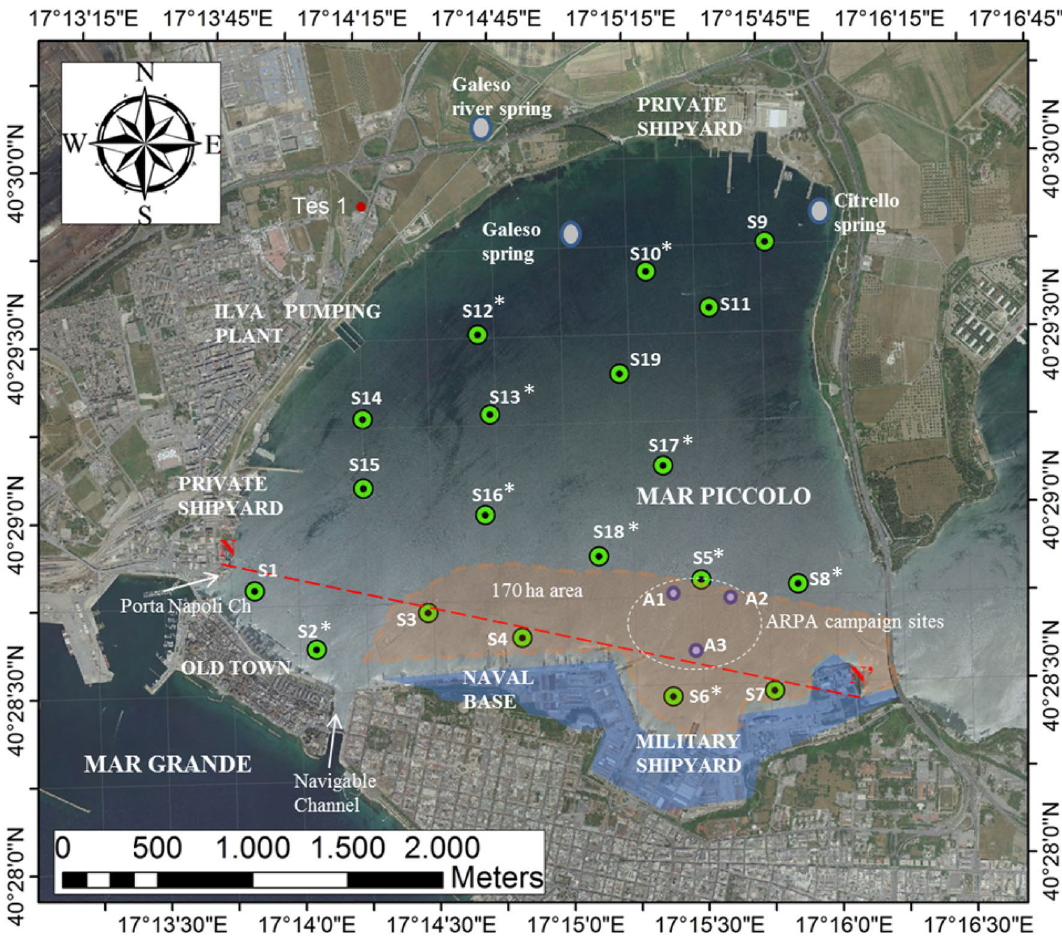
Figure 2. I Bay of the Mar Piccolo basin: boreholes and sampling sites of the 2017 investigation campaign promoted by the Special Commissioner (S sites) and of the campaign by ARPA in 2013 (A sites). Red dashed line indicates the trace of section N–N ′ . (*) sites equipped by piezocone tests. The map was obtained by co-authors through QGIS—software (version 3.14.16); https ://eur03 .safel inks.prote ction .outlo ok.com/?url=https %3A%2F%2Fwww .qgis.org%2Fen%2Fsit e%2F&amp;data=04%7C01%7C%7Ca2e ff60f e9454 19600 8a08d 8b0b2 0556%7C5b4 06aab a1f14 f13a7 aadd5 73da3 d332%7C0%7C0%7C637 45362 59383 25668 %7CUnk nown%7CTWF pbGZs b3d8e yJWIj oiMC4 wLjAw MDAiL CJQIj oiV2l uMzIi LCJBT iI6Ik 1haWw iLCJX VCI6M n0%3D%7C100 0&amp;sdata =J6w9D Tllpa V5Eyn faYk%2B2iG RAyDA imzXd Oh6u1 0%2FXJQ %3D&amp;reser ved=0), license Creative Commons. Attribution-Share Alike 3.0 licence (CC BY-SA) integrated with ESRI World